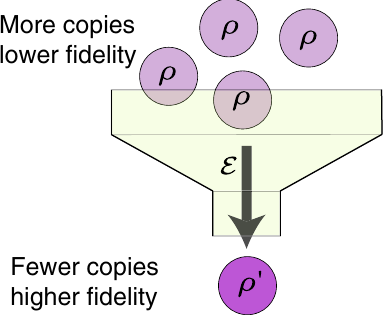
FIG. 1. An outline of a single round of magic-state-distillation protocol. Within many architectures of fault-tolerant quantum computing, a large proportion of the device is committed to these magic-state factories. Each attempt uses n copies of a state (cid:1) and when successful outputs a state (cid:1) 0 / E ð (cid:1) (cid:1) n Þ . For n given suc- cessful attempts, the output states are used as inputs into the next iteration. Within the magic-state model, the completely positive map, E , is composed of a sequence of Clifford unitaries and Pauli measurements. This figure illustrates a protocol where n ¼ 4 , for example, the ququint, d ¼ 5 , protocol that we discuss through- out